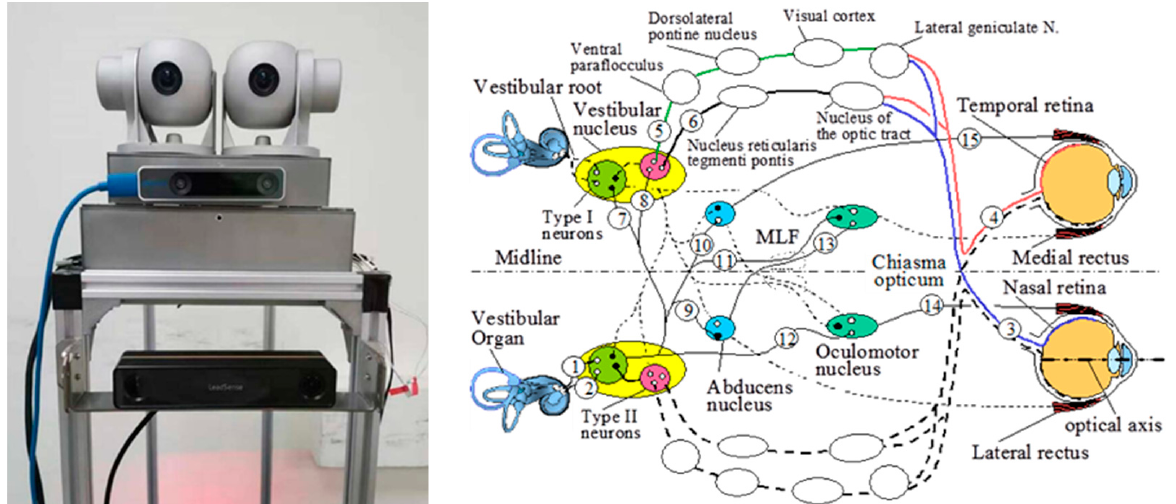
Figure 9. Bionic eye and algorithm model developed by Xiaolin Zhang’s team. The visual pathway algorithm model that mimics the chiasma principle is depicted in ICONS: 1 (cid:13) – 15 (cid:13) . Copyright citation: This image is licensed by IEEE.